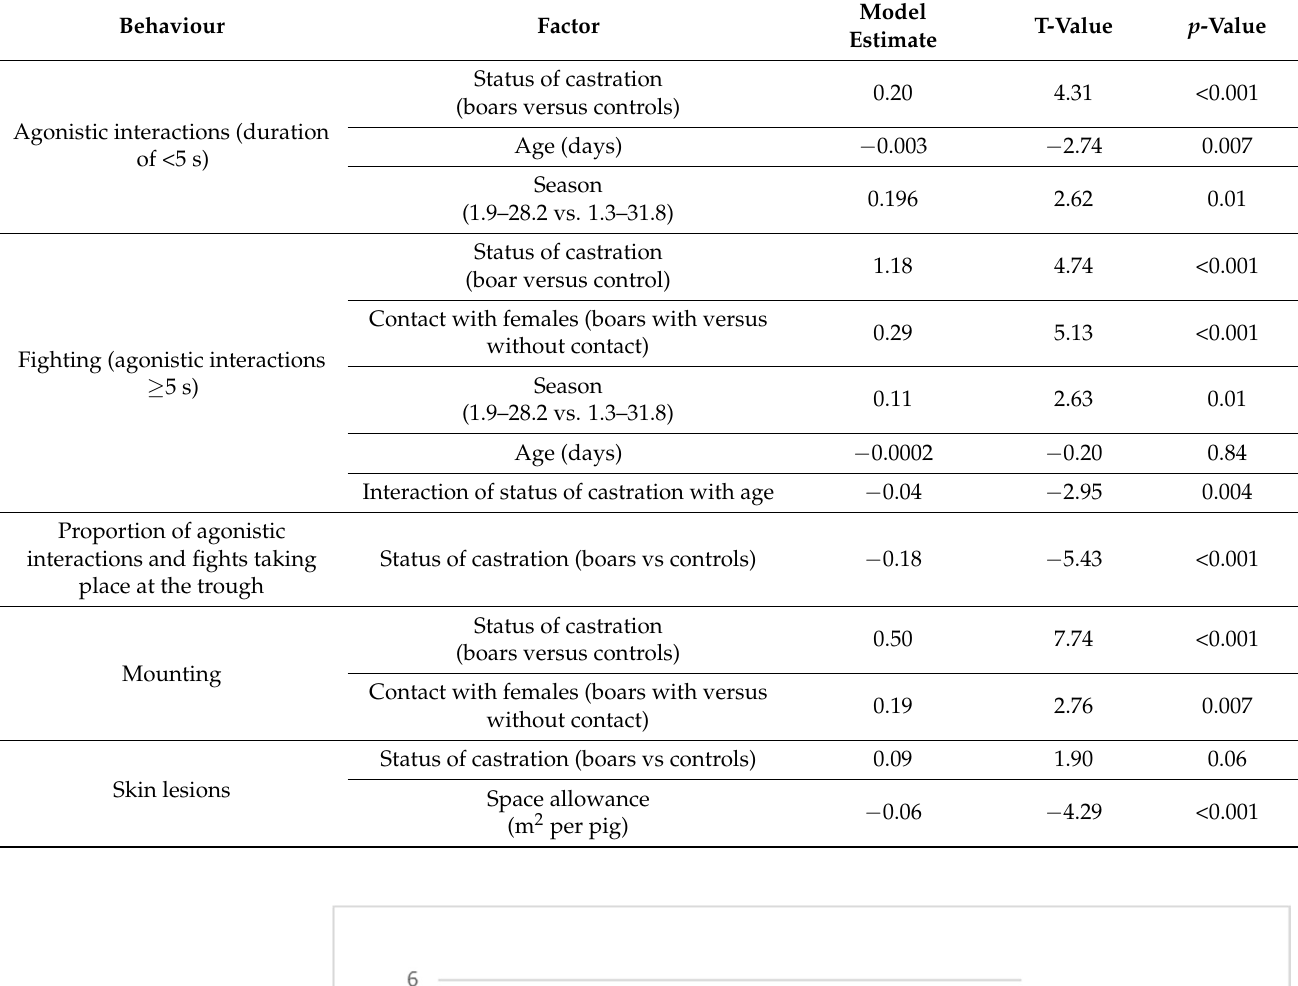
Table 6. Final results of linear mixed models regarding possible effects on different social interactions. Table 5. Environmental conditions at the days of observation and body weight measures.